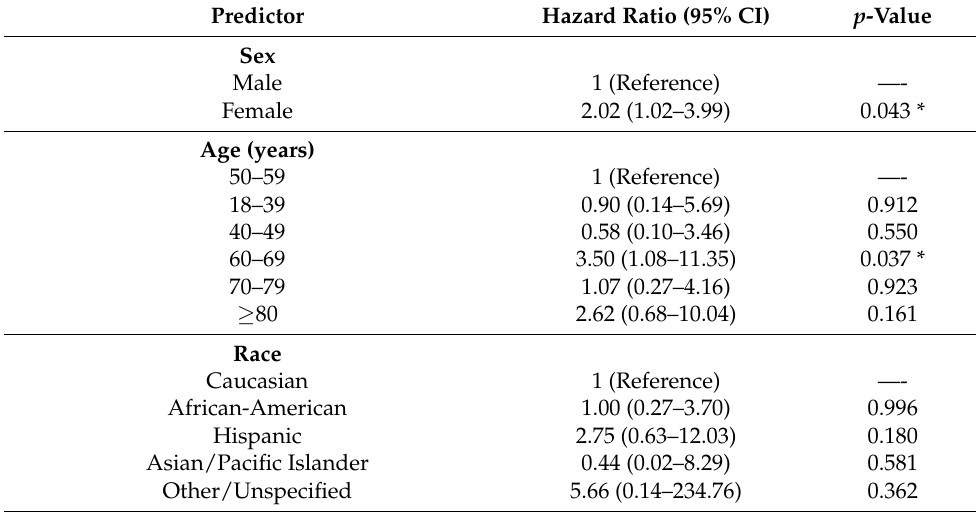
Table 3. Cox proportional hazards regression to identify independent predictors of increased risk of